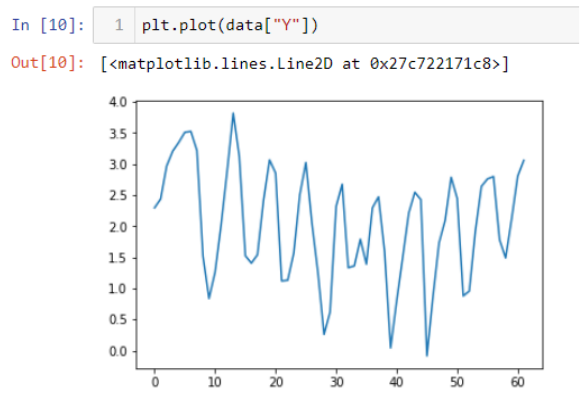
Figure 41. Visualization of data ( x -axis).